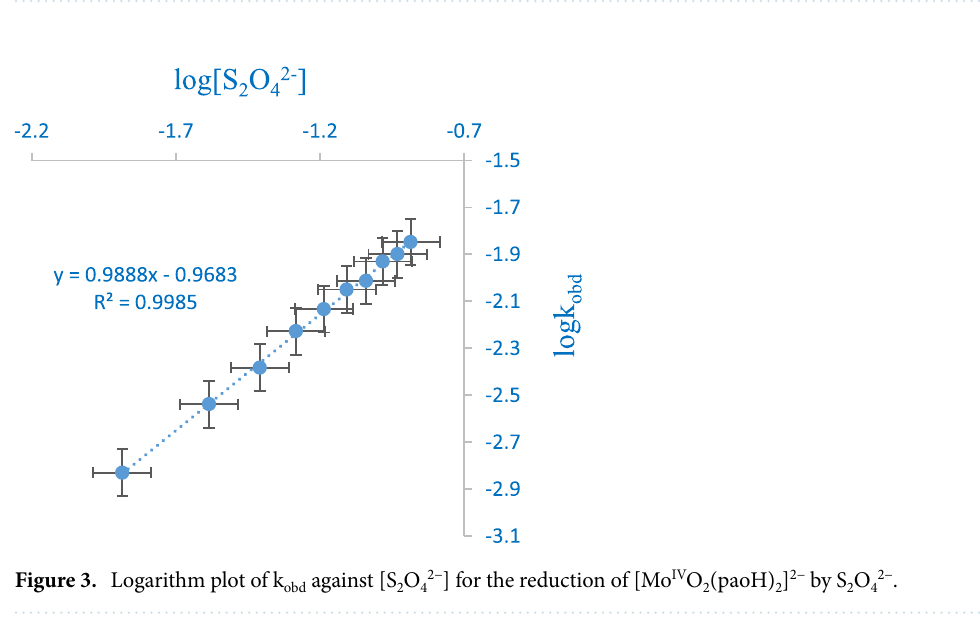
Figure 2. Nonlinear least square graph of InA against time for the reduction of [Mo IV O 2 (paoH) 2 ] 2− by S 2 O 4 2− .